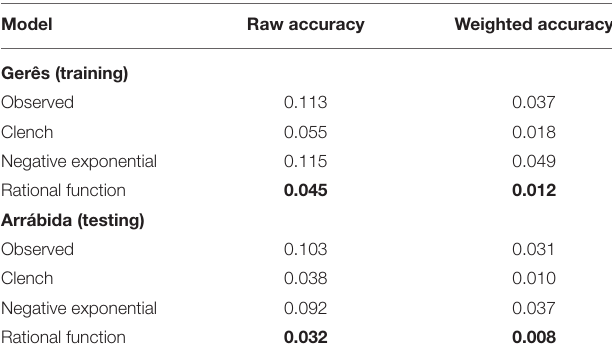
TABLE 3 | Comparison of three asymptotic equations used to estimate spider species richness in two forest